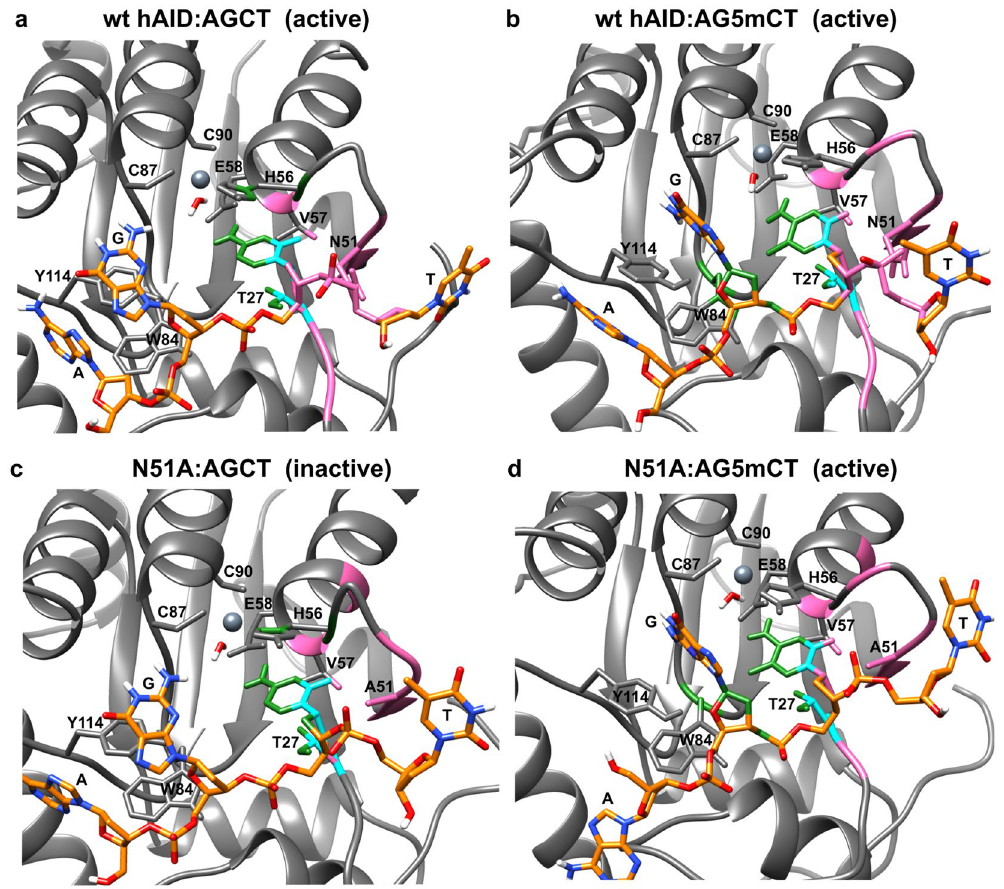
Figure 6. Interactions formed by N51 or A51 residue and methyl group or C5 atom within analyzed complexes: ( a ) wt hAID:AGCT, ( b ) wt hAID:AG5mCT, ( c ) N51A:AGCT, and ( d ) N51A:AG5mCT. The secondary structures of wt hAID and the N51A mutant are shown in gray. The selected amino acid residues that form catalytic pockets of these enzymes are indicated. The dark gray sphere represents zinc ion. The tetranucleotide substrates (AGCT or AG5mCT) docked to the catalytic pockets are shown in orange. The range of interactions of N51 or A51 residue is shown in pink. The range of interactions of the methyl group (of 5 mC) or the C5 atom (of C) is shown in green. The superposition of these two zones is shown in light blue. N51 interacts with an extensive part of the ssDNA sugar-phosphate backbone that joins C and T (within the AGCT/AG5mCT motif). A51 does not form these interactions. Specific to the methyl group are interactions with T27, W84 and an ssDNA sugar-phosphate backbone that joins C and G (within the AGCT/AG5mCT motif). In the N51A:AGCT complex, the ssDNA backbone is not anchored. Stacking interactions between W84, Y114, and G are stable only in complexes with a non-methylated substrate (wt hAID:AGCT,